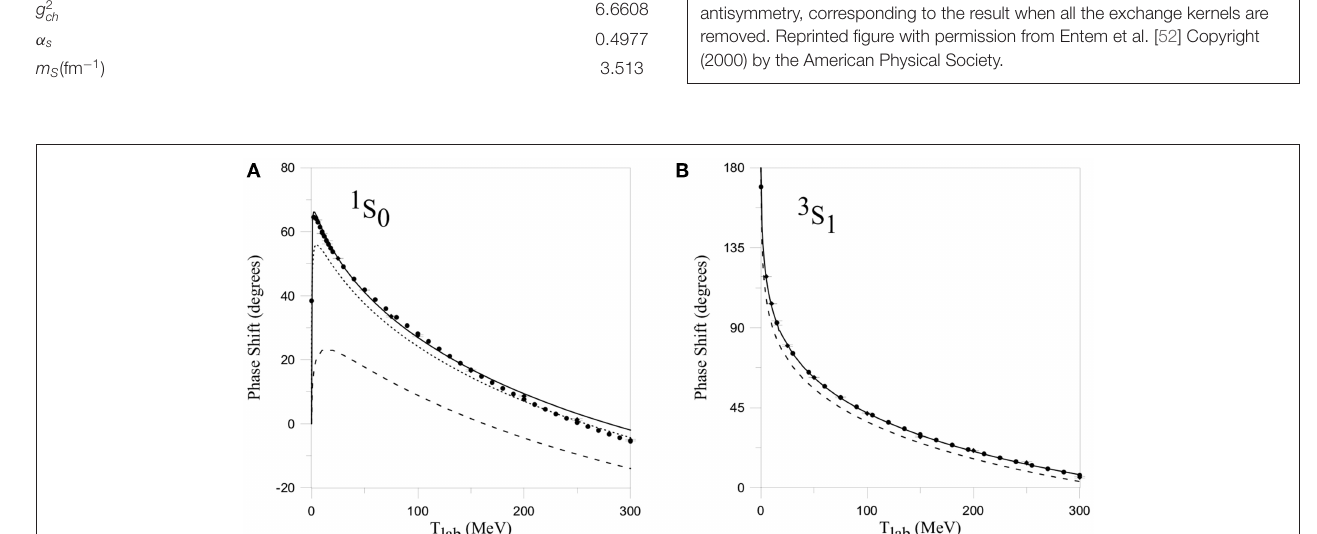
FIGURE 4 | NN S wave phase-shifts for T 1 (A) and T 0 (B) . Experimental points with and without error bars correspond to the energy independent and energy = = dependent solutions of Arndt et al. [59], respectively. The phase shifts are shown and the analysis correspond to neutron-proton. (A) Dashed line represents the calculation including NN channels only, dotted line includes also N 1 components, and solid line is the full calculation with NN , N 1 , and 11 channels. (B) Dashed line is the calculation with NN only, and the solid line is the full calculation including NN and 11 channels. Reprinted figure with permission from Entem et al. [52] Copyright (2000) by the American Physical